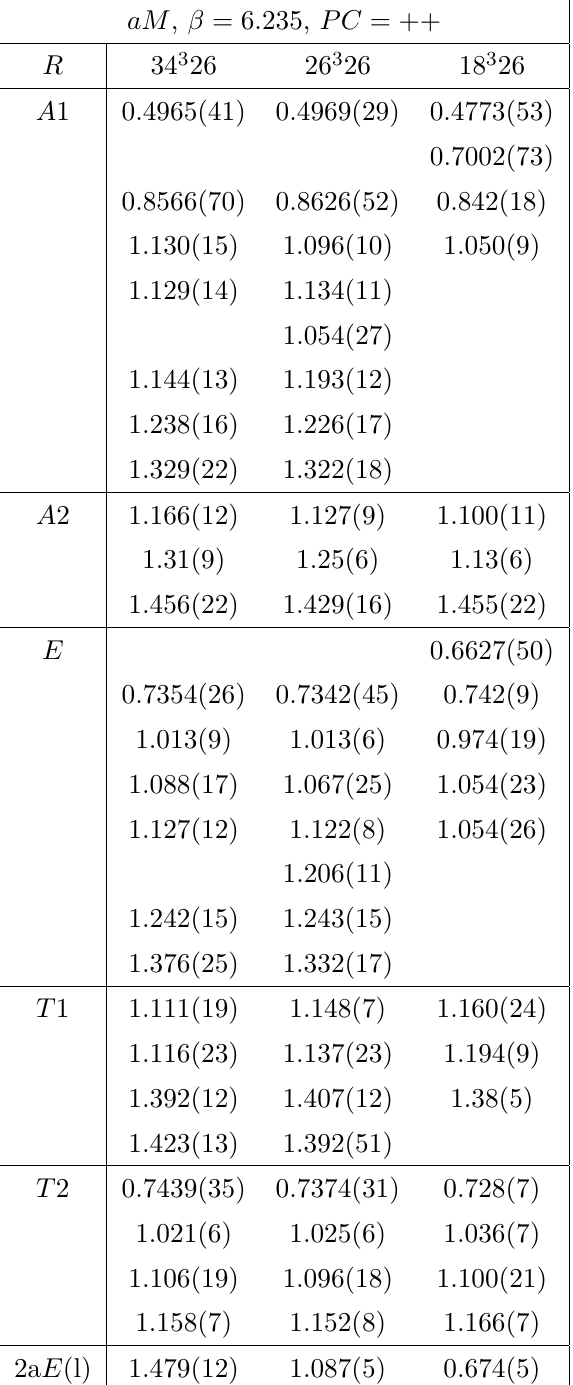
Table 3 . Finite volume check on glueball masses with P = + and C = + at β = 6 . 235 on the lattices shown. The masses are extracted from the same initial time and are not always the same as our best mass estimates listed in other tables. Intemediate gaps appear where there is a clear extra state on a smaller lattice. Last line gives twice the energy of a winding flux